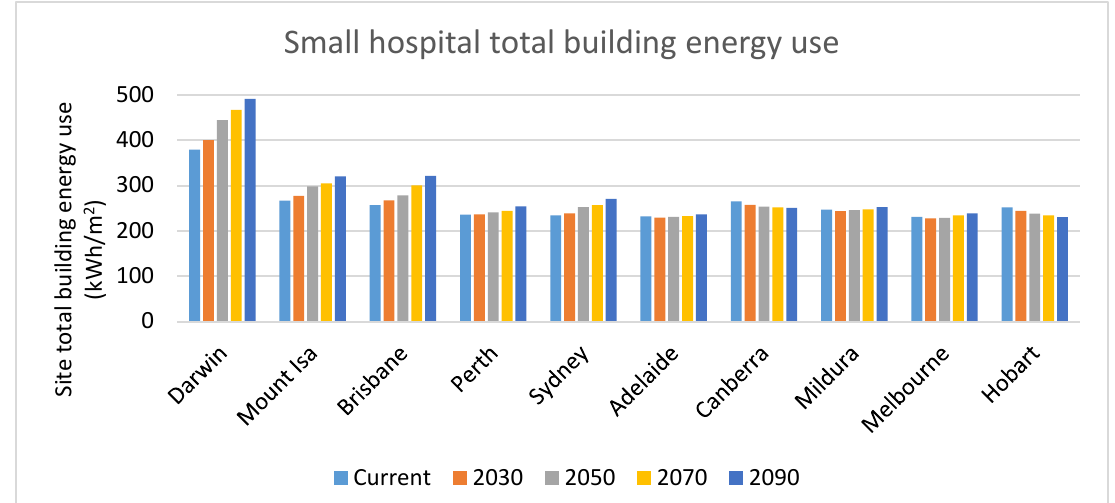
Figure 11. Small hospital’s yearly site total energy use in kWh/m 2 .